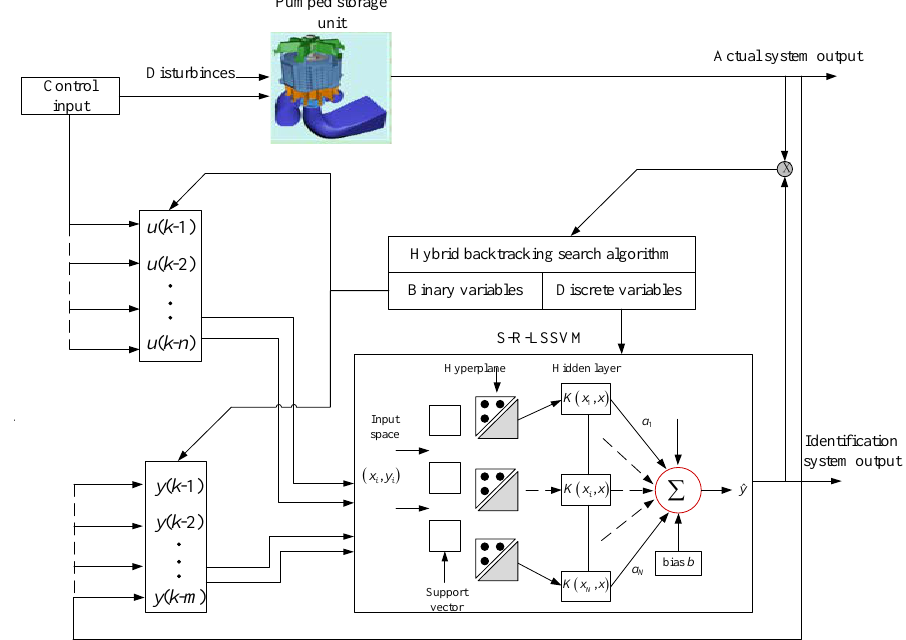
Figure 3. Synchronous optimization of the S-R-LSSVM model based on the HBSA for the pumped turbine governing system (PTGS).